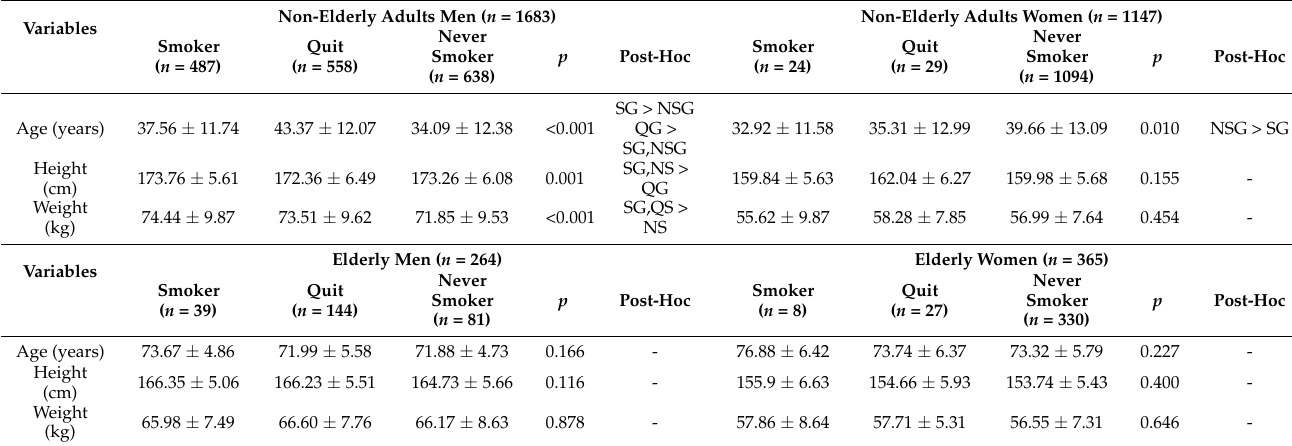
Table 1. Demographics and physical characteristics of non-elderly adult and elderly participants.